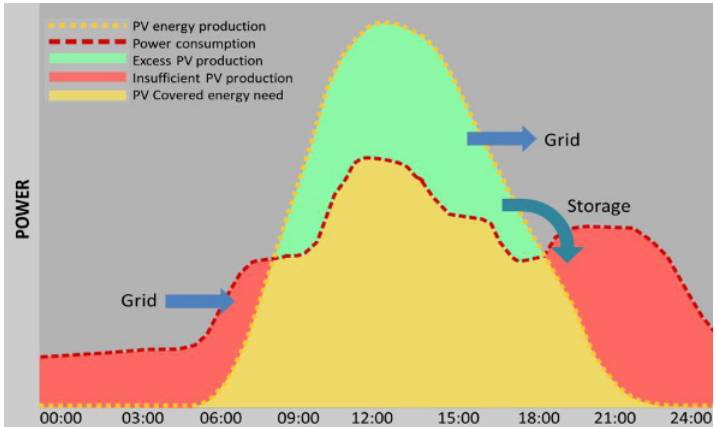
Fig. 1. Daily energy production of a ‘standard’ roof-sized photovoltaic (PV) system superimposed on the average power consumption of a northern European household on a summer